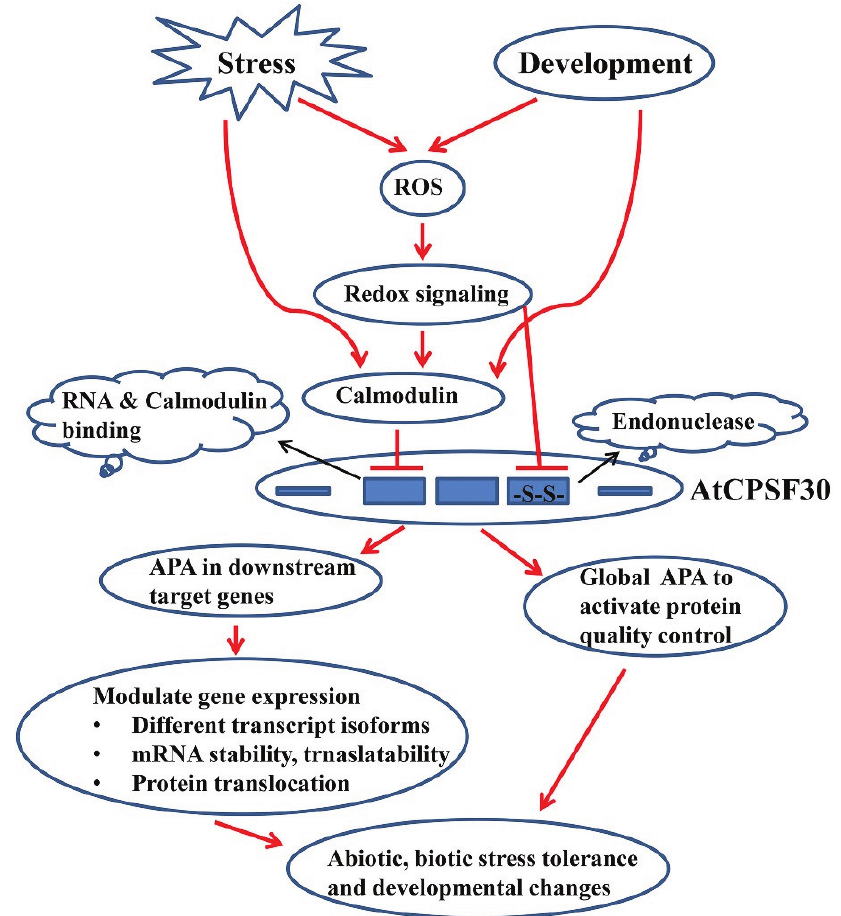
Figure 3. Model depicting possible links between environmental stresses, developmental cues, cellular signaling and AtCPSF30-regulated polyadenylation. Three conserved zinc finger domains of AtCPSF30 are shown with thick blue rectangles. Pertinent biochemical activities are represented as clouds and linked to the respective zinc finger motifs with black